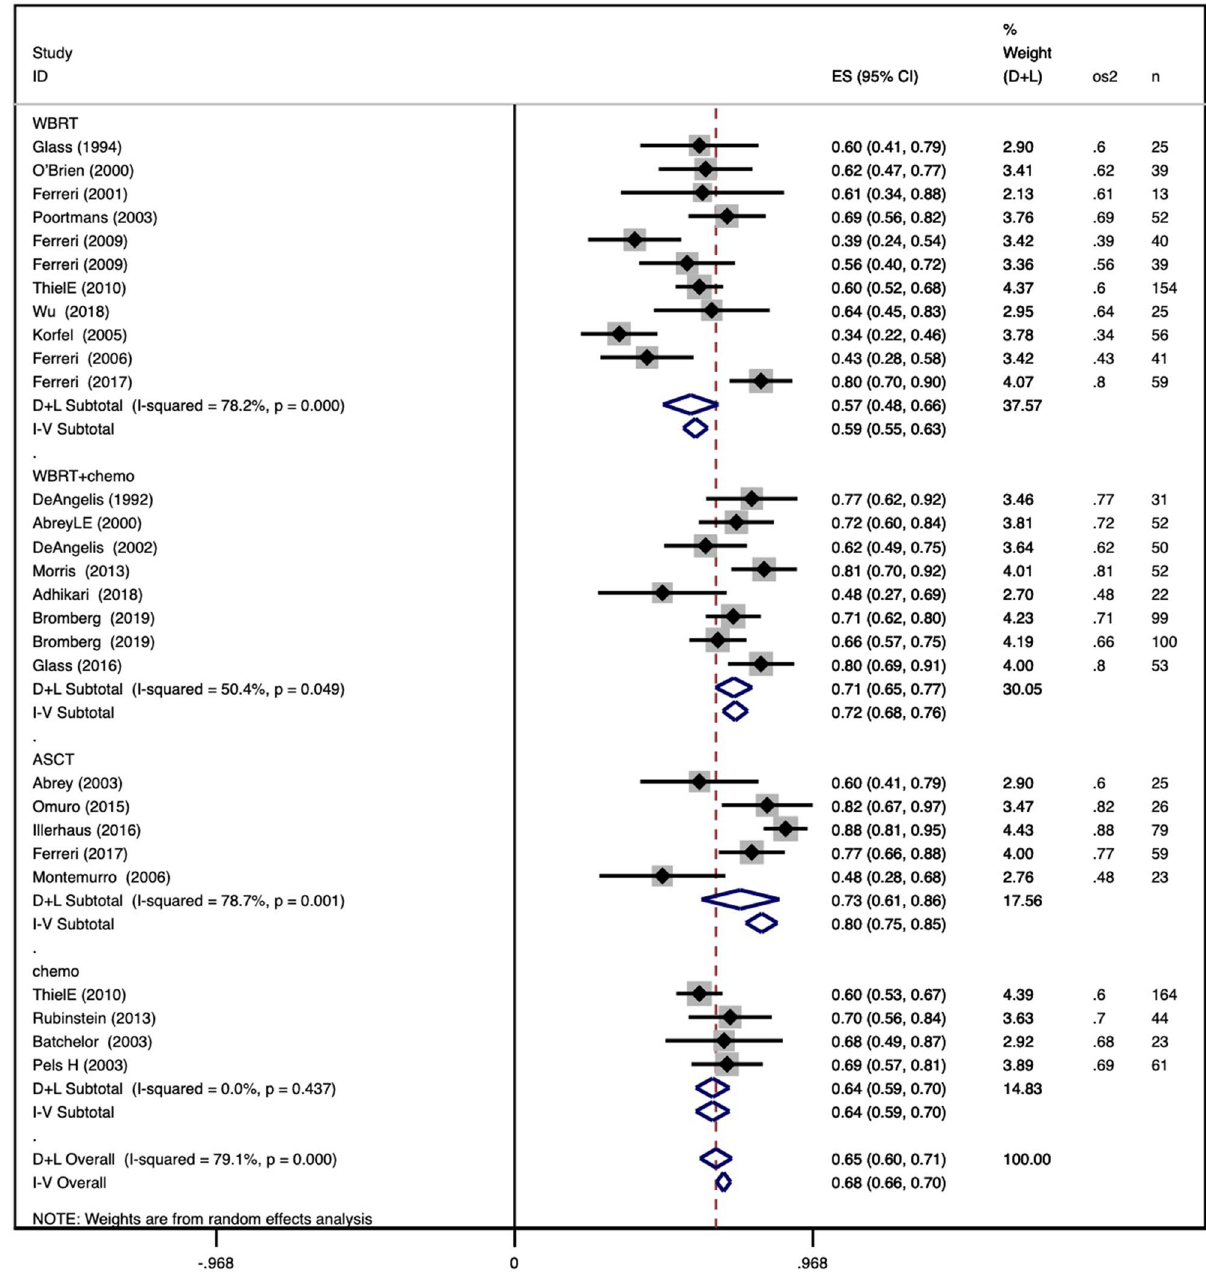
Figure 2. Forest plot of 2-year and 5-year overall survival within different consolidation methods. ( a ) Pooled 2-year overall survival for WBRT, WBRT + chemotherapy, ASCT, and chemotherapy-only consolidation; ( b ) pooled 5-year overall survival for the four consolidation